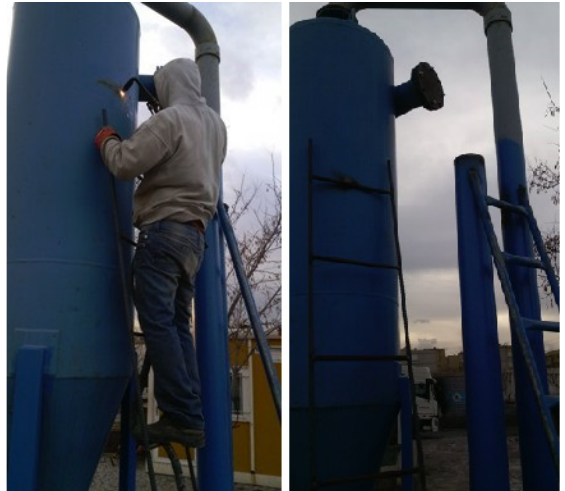
Fig. 3. Stages of cutting inlet gate to hydrocyclone